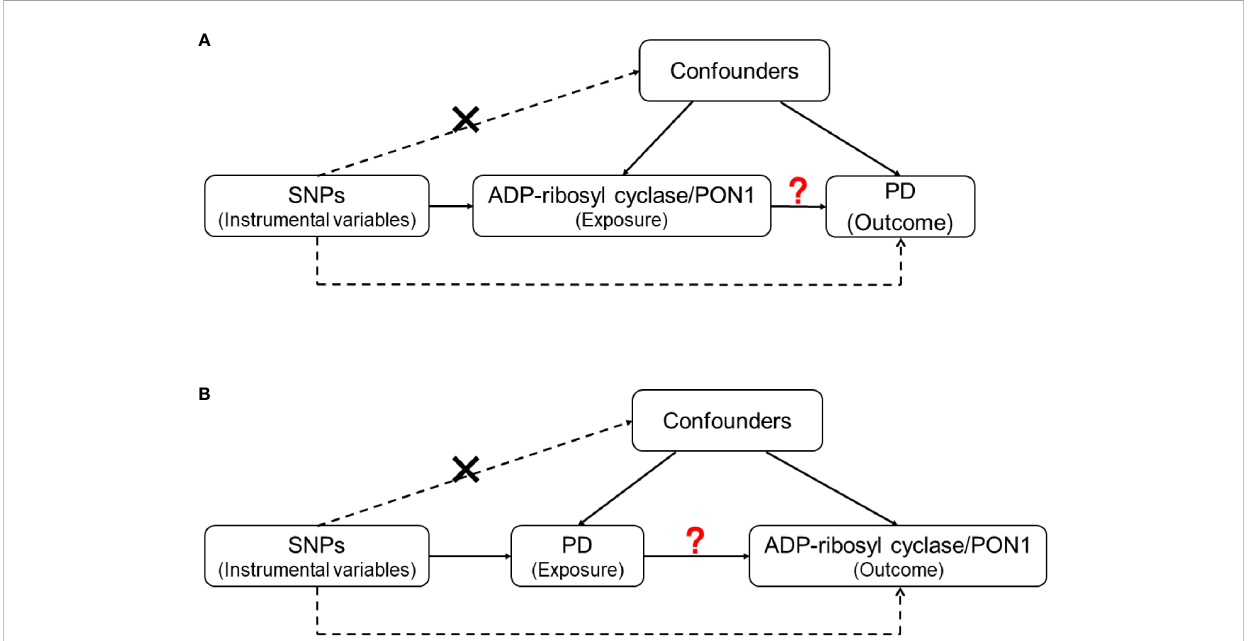
FIGURE 2 The design of Mendelian Randomization (MR) analysis to assess causality between PD and proteins coded by in fl ammatory genes. (A) SNPs independently associated with ADP-ribosyl cyclase (coded by BST1 ) and PON1(coded by PON1 ) from GWAS summary statistic were used as instrumental variables to explore the causal effect of ADP-ribosyl cyclase and PON1 on PD. (B) SNPs independently associated with PD from GWAS summary statistic were used as instrumental variables to explore the causal effect of PD on ADP-ribosyl cyclase and PON1 respectively. In